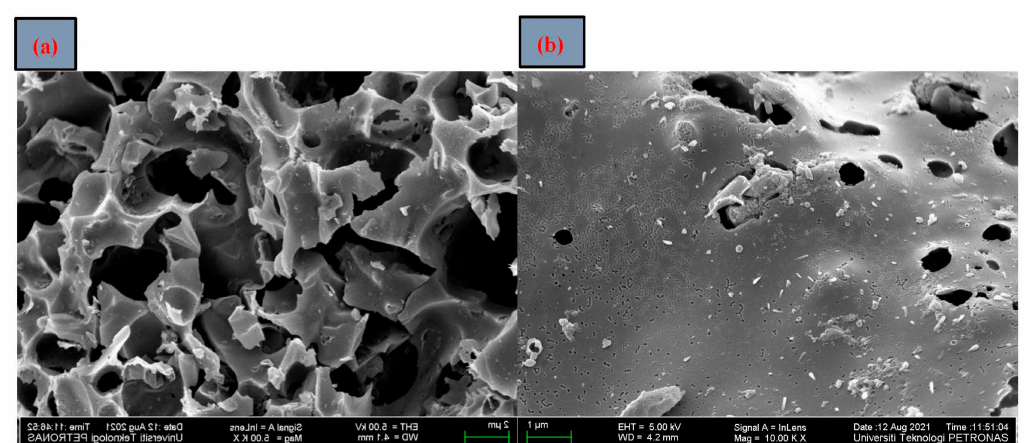
Figure 2. FESEM electron images at ( a) 2 µ m, ( b ) 1 µ m for HWSB.